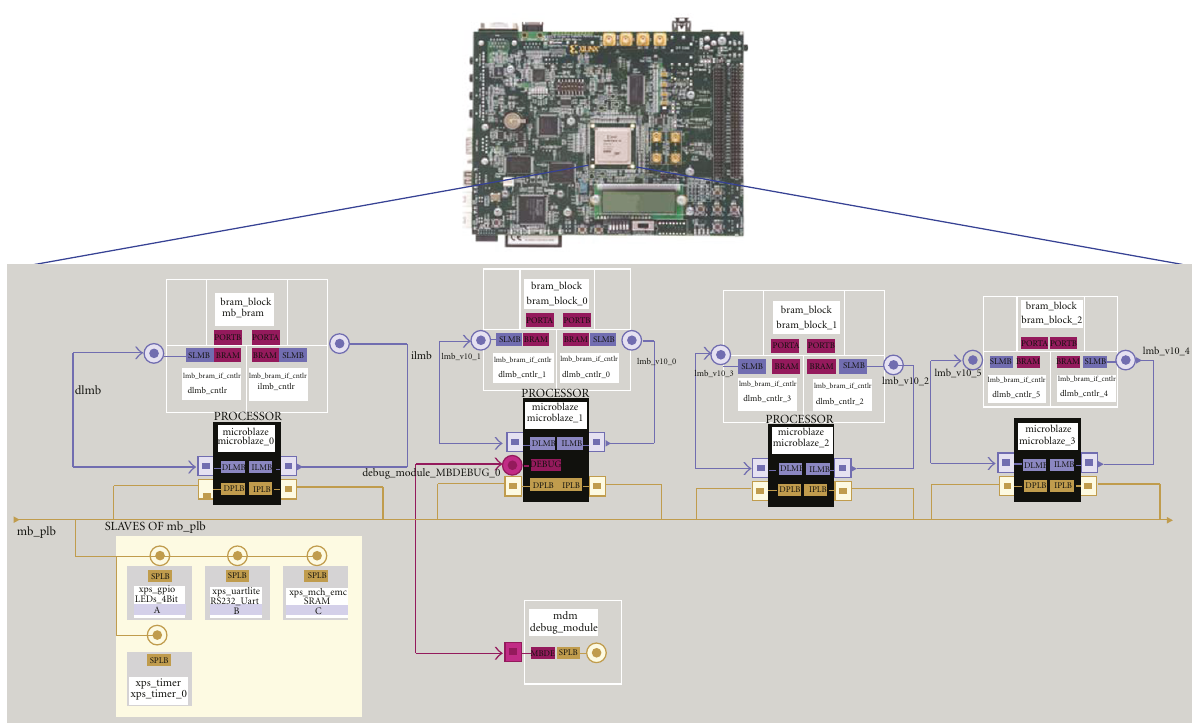
Figure 4: The ML405 board hosting a Virtex4-FX20 1MB SRAM and 128 MB DDR memory; the 4-MicroBlaze system-on-FPGA